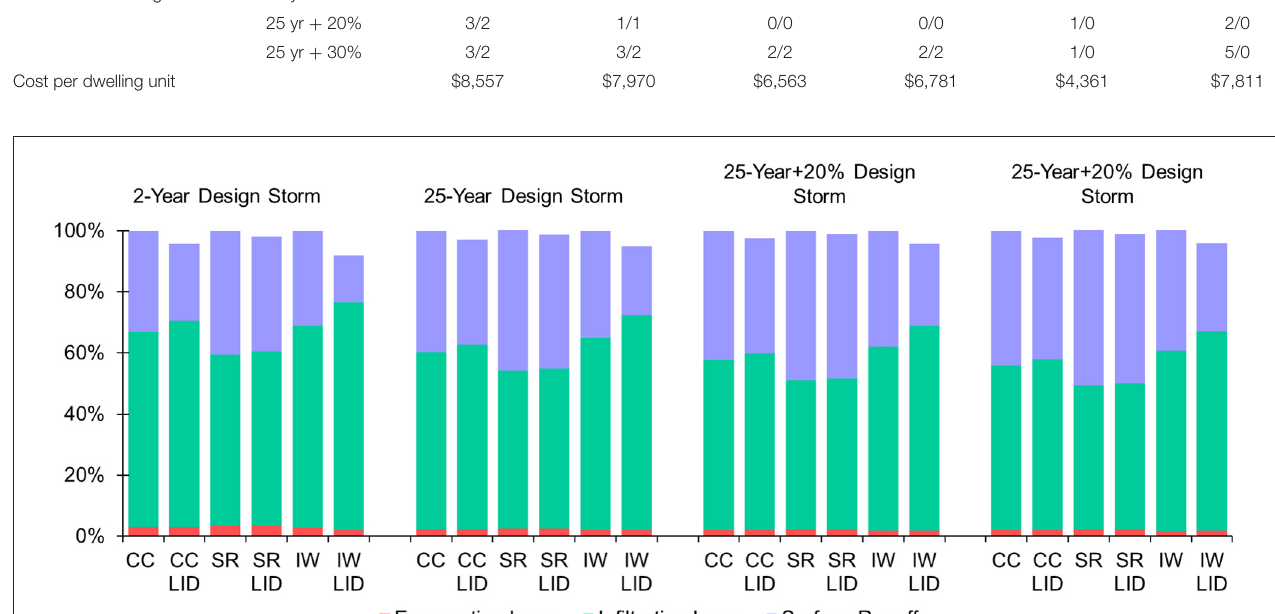
FIGURE 2 | Results of design storm simulations showing the fate of precipitation (infiltration, runoff, and evaporation) for each 24-h design storm; 2-year storm, 25-year storm, 25-yeatr + 20%, and 25-year + 30%.